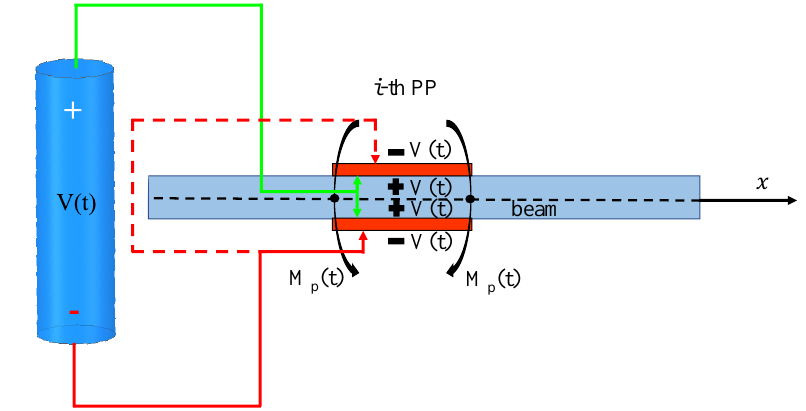
Figure 2. i -th PZT actuator pair actions induced on the